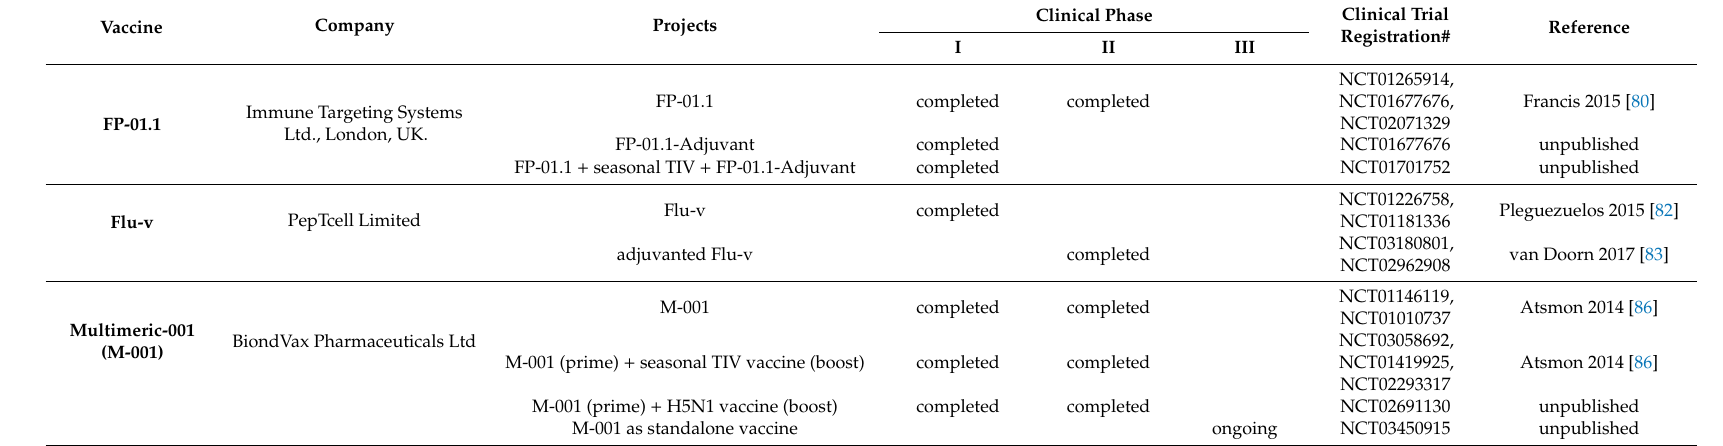
Table 2. Promising epitope-based universal influenza vaccines at clinical